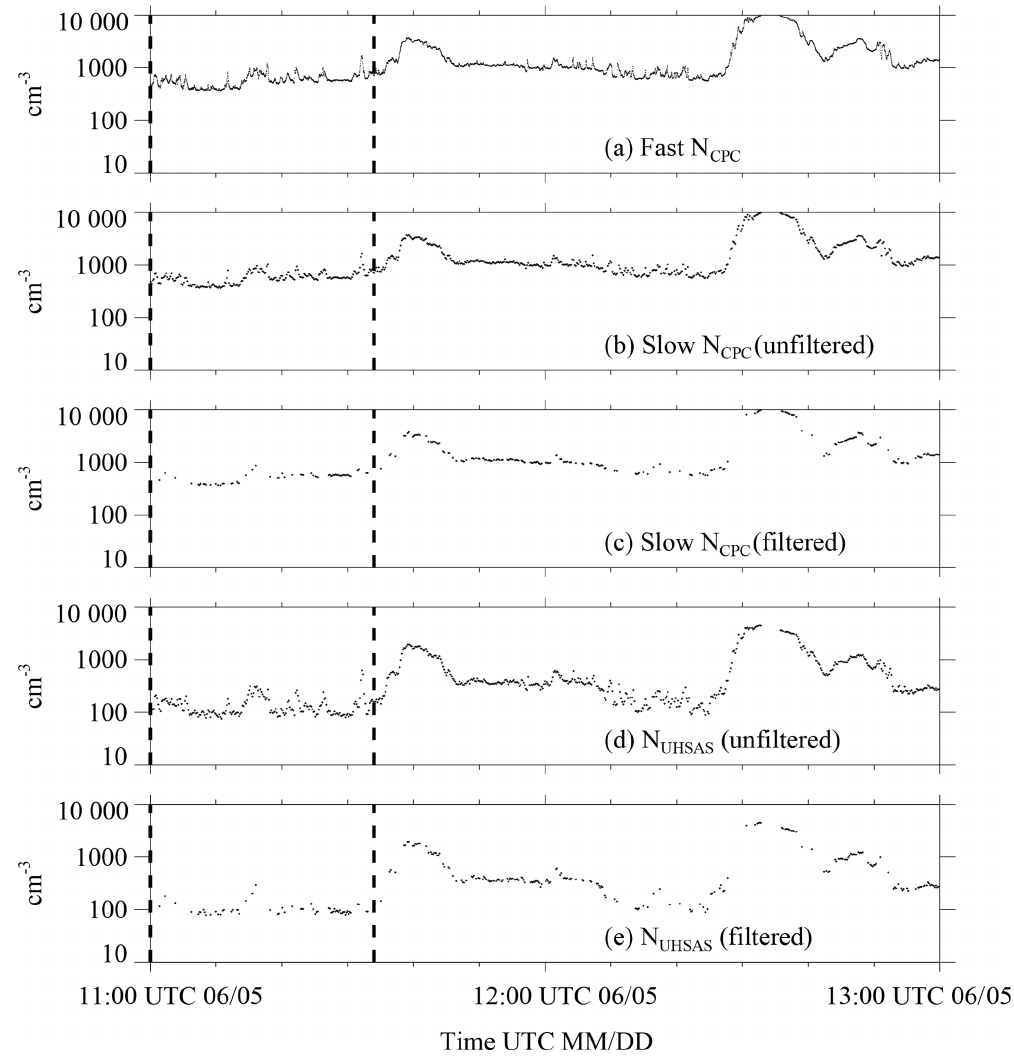
Figure B1. Demonstration of the numerical filter. Measurements from one of the 20 onshore trajectories that arrived at the Arauco site between 29 May and 28 June. This trajectory arrival occurred at 12:00UTC 5 June: (a) 1s sampled CPC measurements, (b) 10s sampled CPC measurements; (c) filtered 10s CPC measurements, (d) 10s UHSAS measurements of size-integrated concentration, and (e) filtered 10s UHSAS measurements of size-integrated